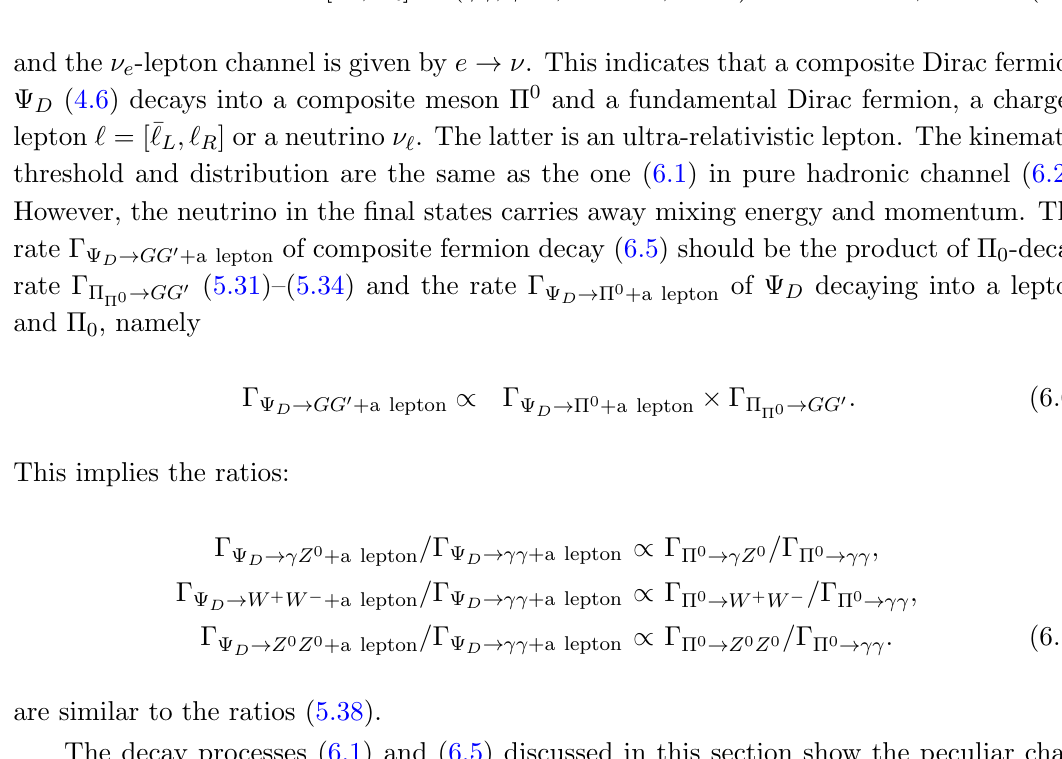
and p γ represent 1 2